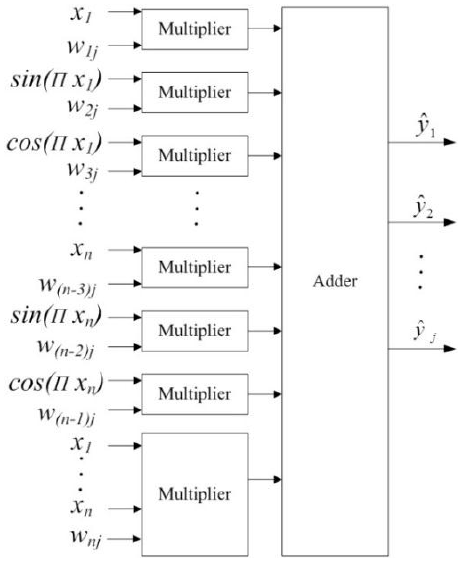
Figure 4. Architecture of FLNN.